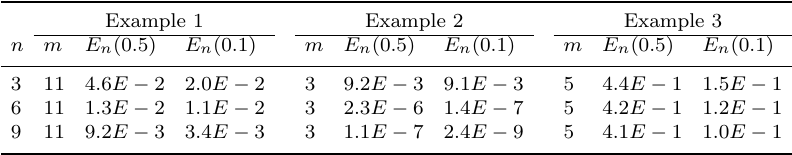
Table 1. Numerical results for Examples 1–3 with noise level 10%.